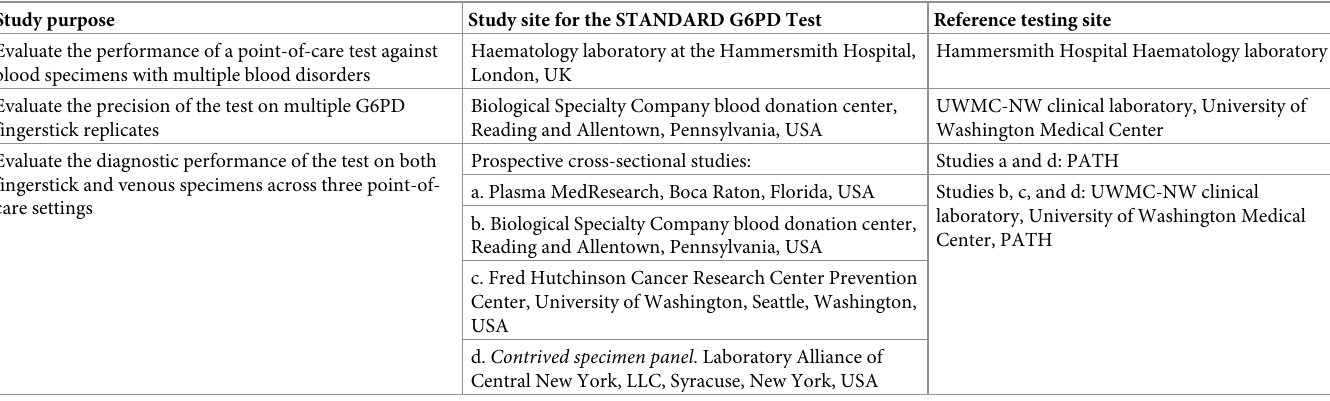
Table 1. Summary of studies conducted to support evaluation of the STANDARD G6PD